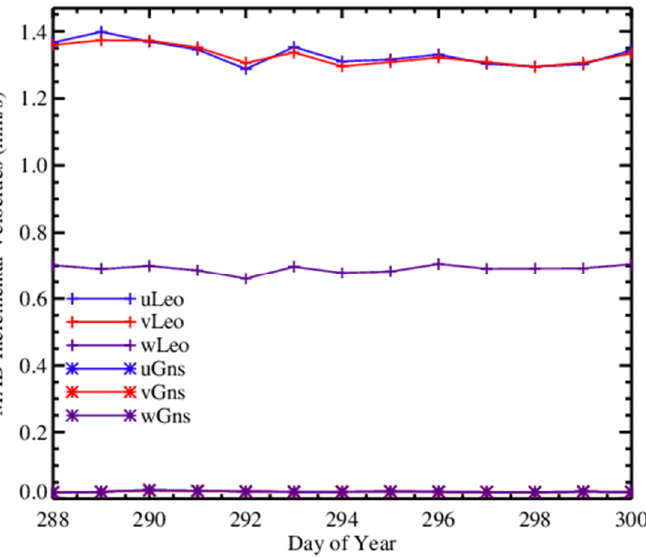
Figure 9. Mean absolute deviation (MAD) of the incremental velocity vectors for October 15 – 27, 2019.